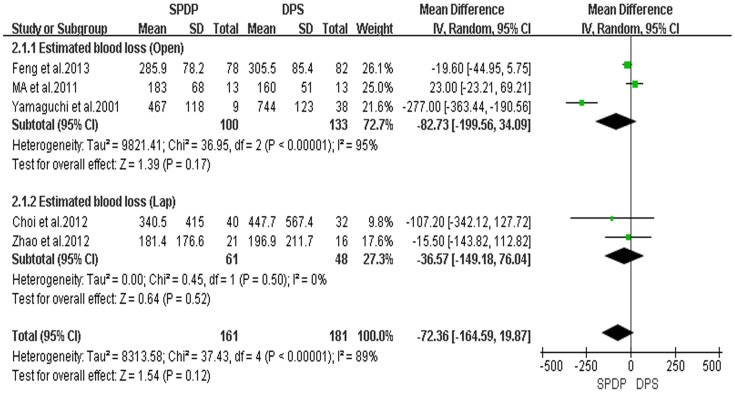
Estimated blood loss (IV, Inverse variance, M-H, Mantel-Haenszel, CI, Confidence Interval; SD, Standard deviation).